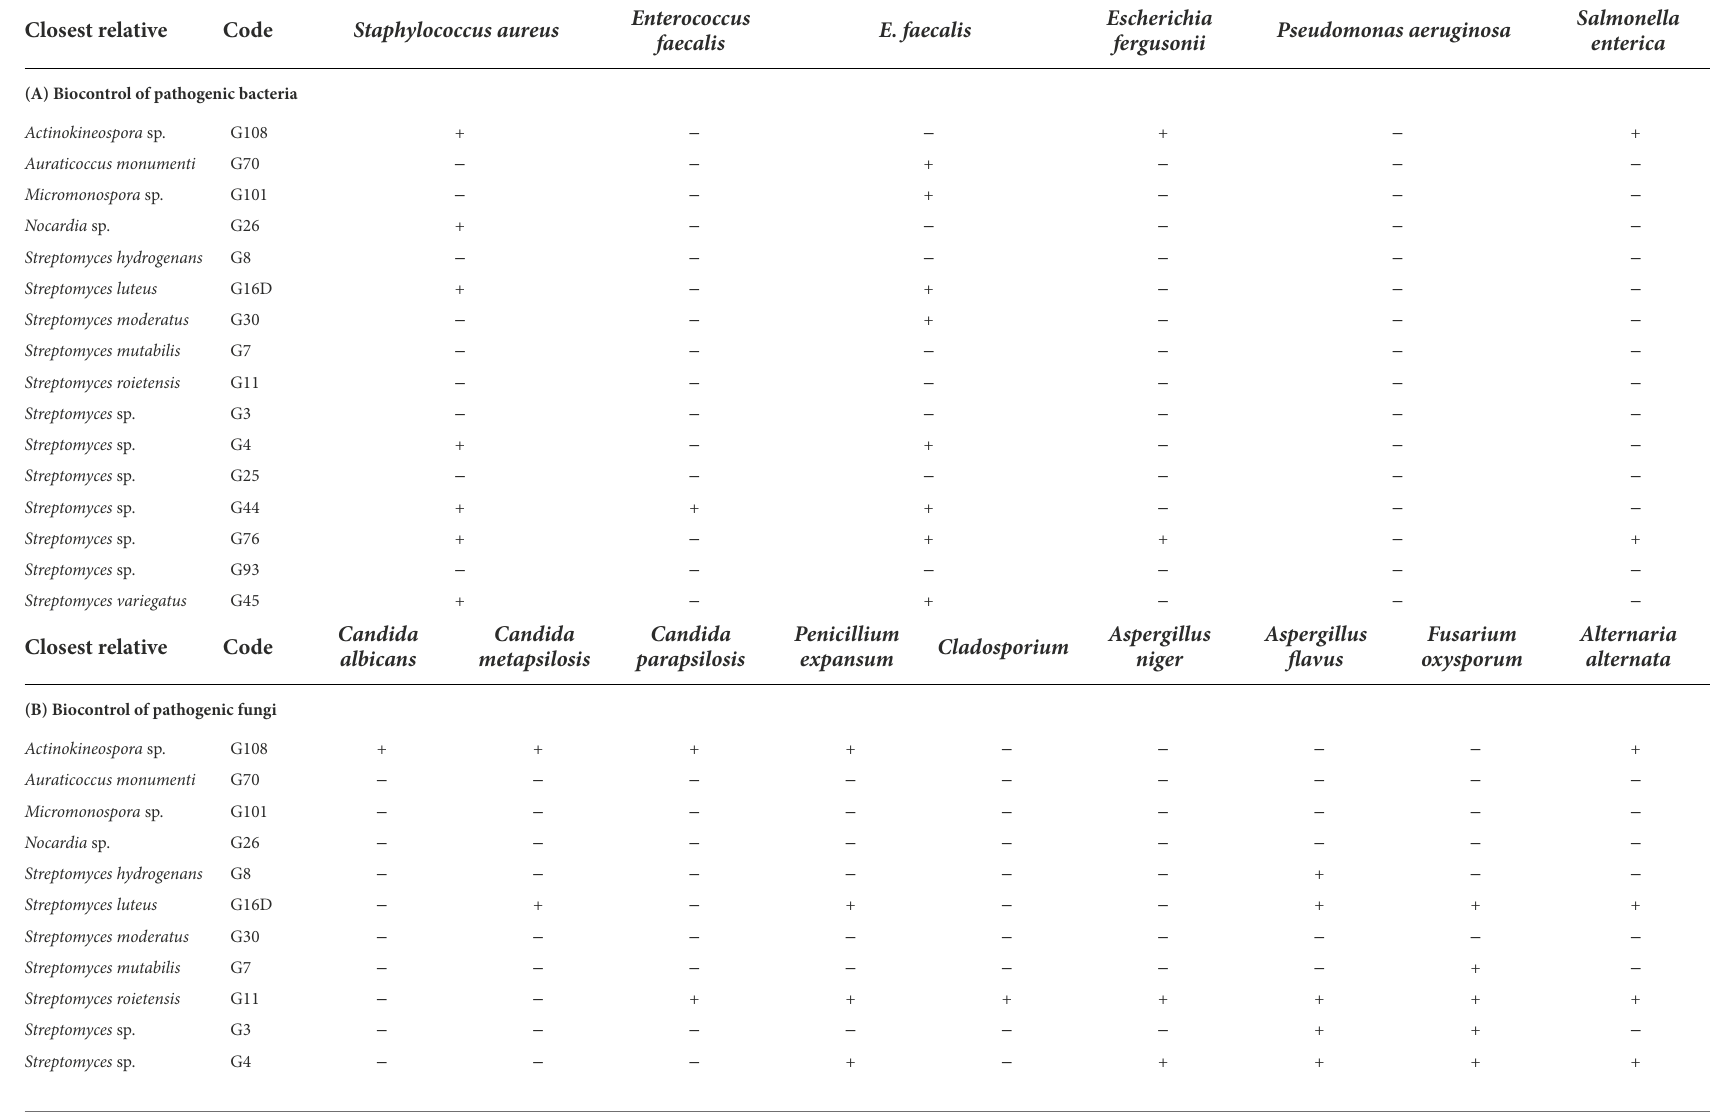
TABLE 3 Biocontrol potential of bacterial isolates against pathogenic (A) bacteria and (B) fungi. Inhibitory profile of the bacterial isolates active at least against one of the pathogens tested, six bacteria and nine fungi.